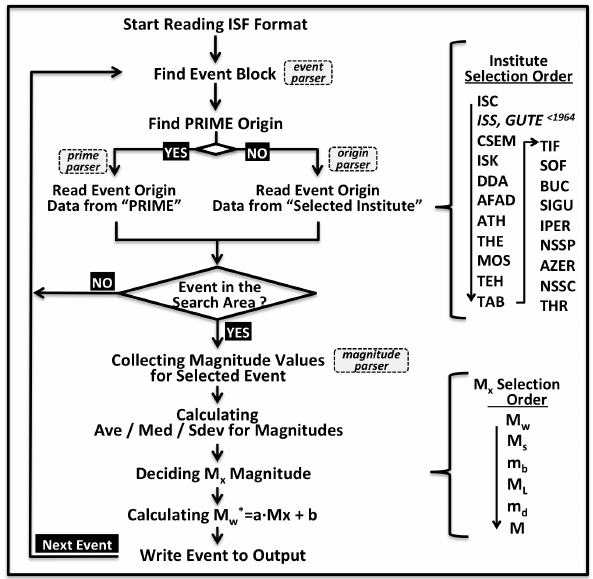
Figure 2. Flowchart of the ISC database processing. Ave: average (mean); med: median; and Sdev: standard deviation. M ∗ w is equiva- lent moment magnitude. See Appendix A for the institute